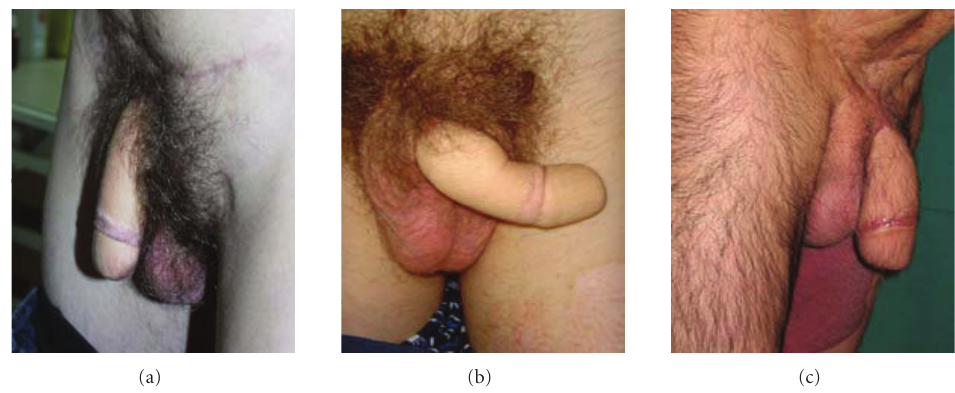
Figure 4: Excellent aesthetic appearence after RFF (a)-(b) and ALTF (c)